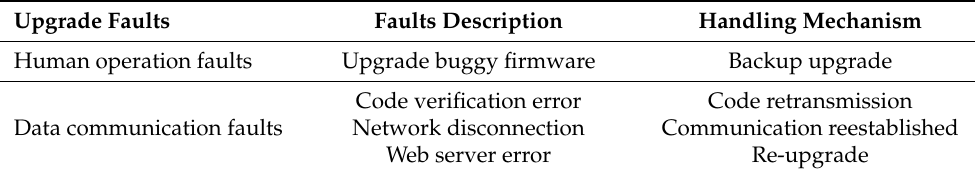
Table 3. Analysis and treatment of upgrade faults.